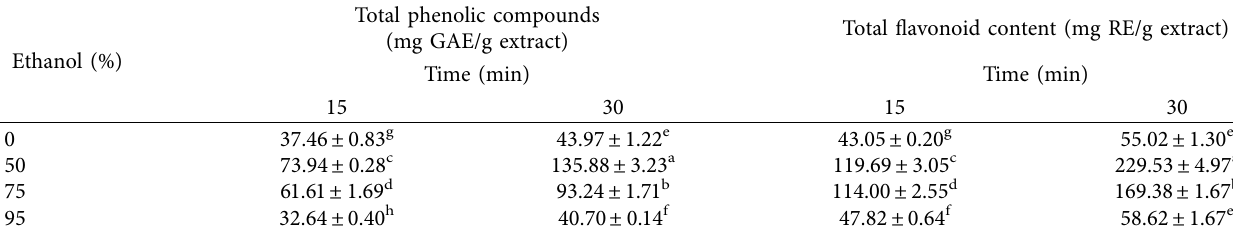
Table 1: Total phenolic compounds and total favonoid content of dill